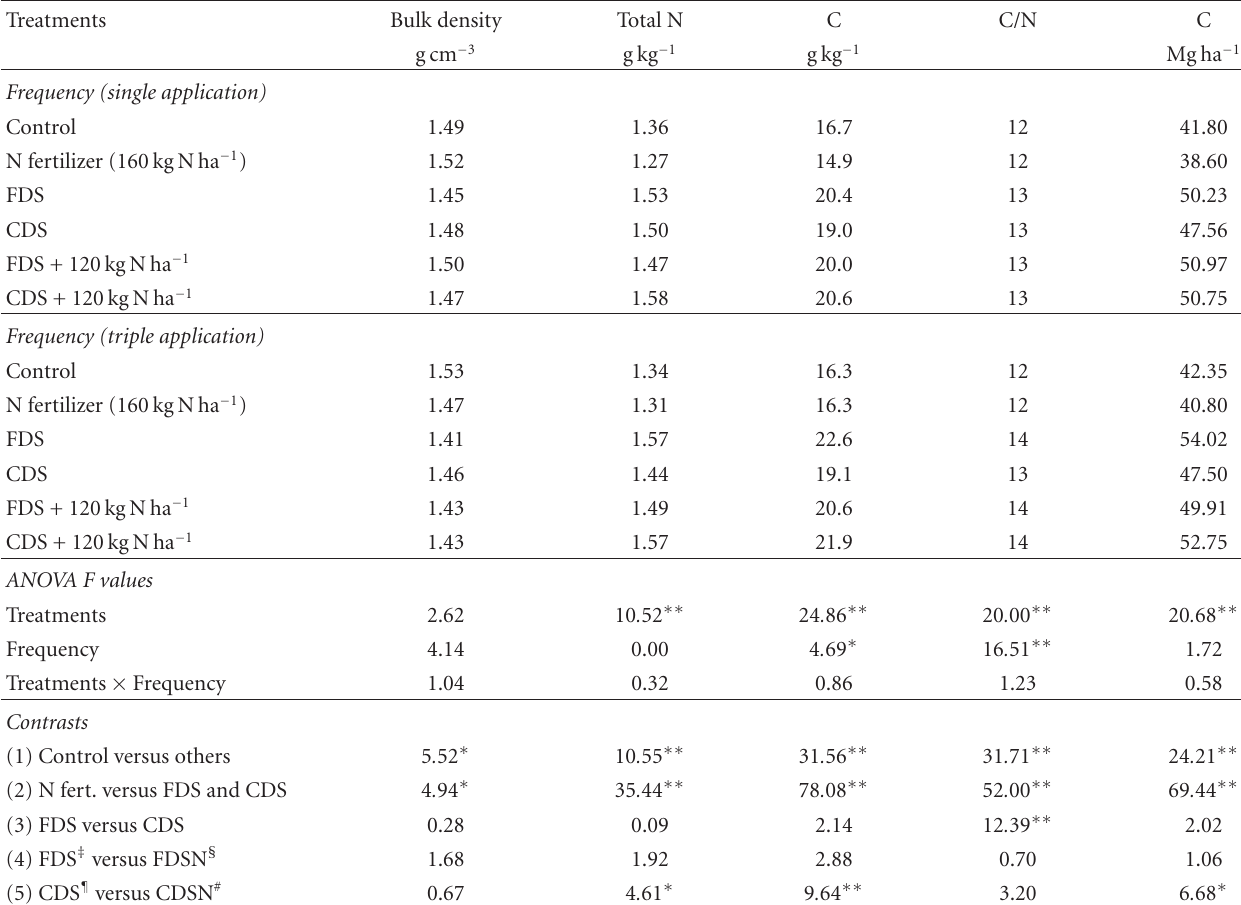
Table 4: Residual e ff ects of applications of fresh and composted paper sludge, and N fertilizer on soil bulk density, nitrogen and